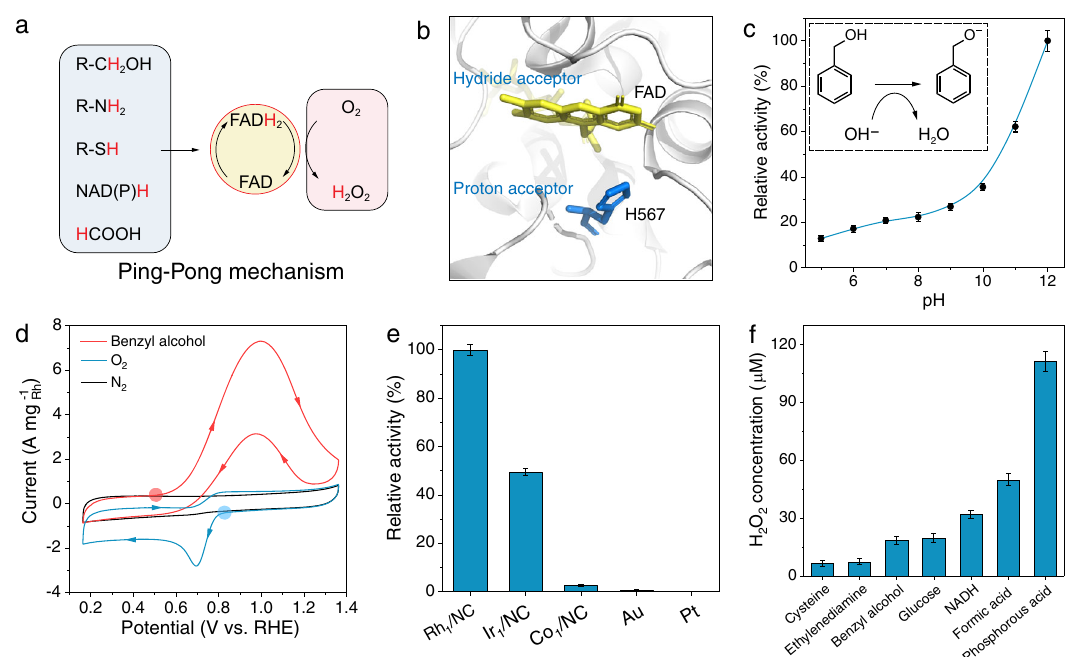
Fig. 3 Oxidase-mimicking activities of metal single-atom catalysts. a Schematic of fl avoenzymes catalyzing the dehydrogenation of various substrates and O 2 reduction to H 2 O 2 . b Active site of the alcohol oxidase from Pichia pastoris . c pH-dependent H 2 O 2 production rate in the Rh 1 /NC-catalyzed benzyl alcohol oxidation reaction. d CV curves of Rh 1 /NC in a N 2 -saturated 0.1 M NaOH + 50 mM benzyl alcohol solution and in N 2 -saturated and O 2 -saturated 0.1 M NaOH solutions with a scan rate of 100 mV s − 1 . e Relative H 2 O 2 production rate in the benzyl alcohol oxidation reaction with different catalysts. f H 2 O 2 concentrations after the reaction of Rh 1 /NC (20 μ g mL − 1 ) and different substrates (10 mM, 0.1 mM for NADH and cysteine) for 5 min. Data are presented as mean values (SD). (The error bar represents the standard deviation of 3 independent